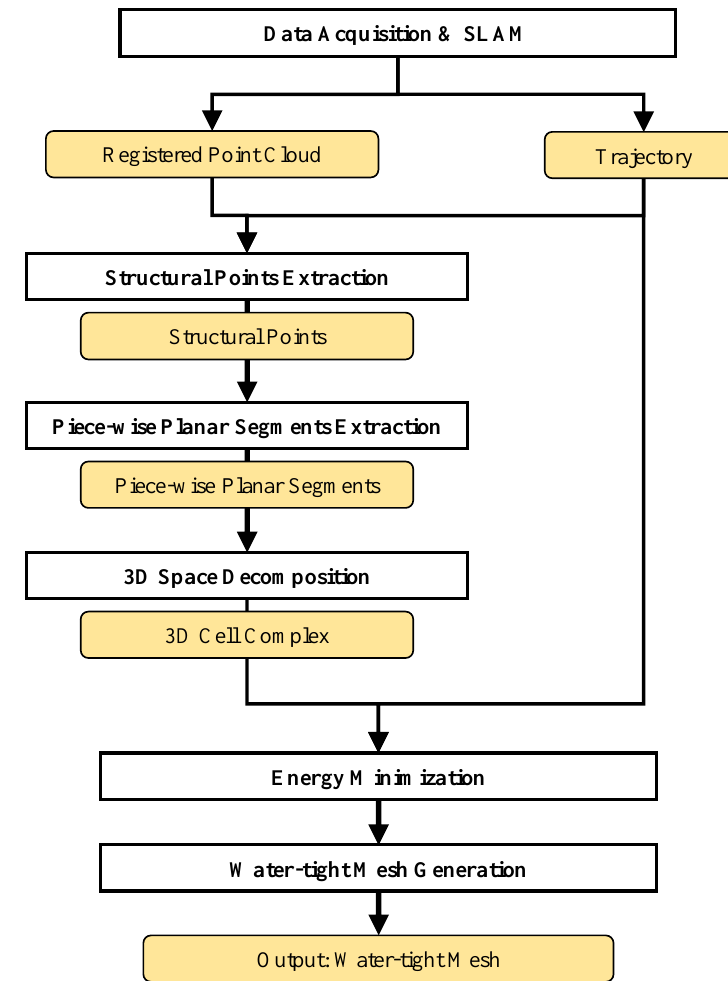
Figure 3. Flowchart of the proposed